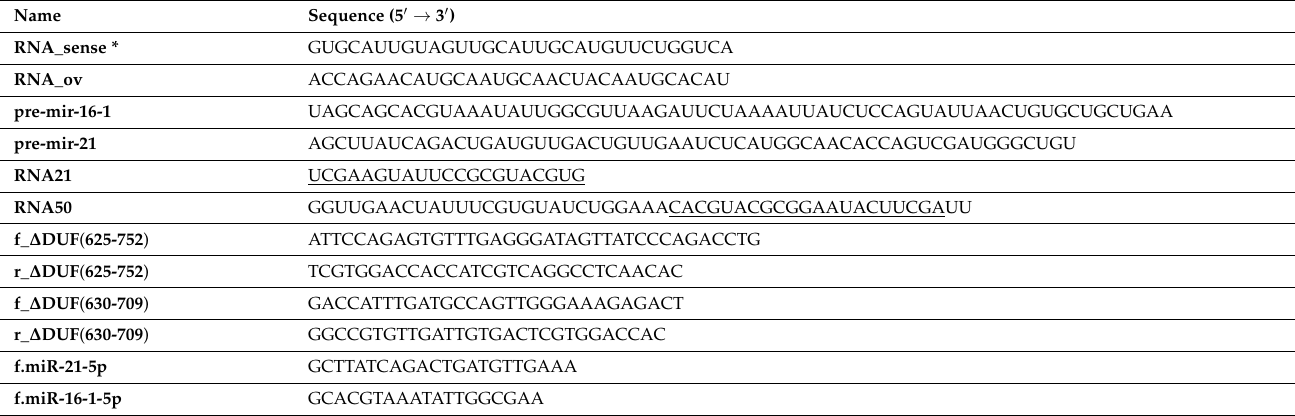
Table 1. Sequences of oligonucleotides used in the